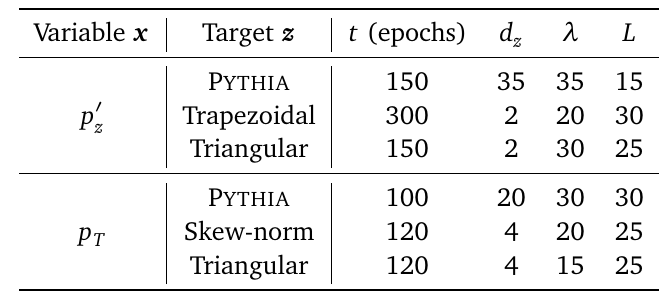
Table 1: The cSWAE training configurations, where x is the input data, z the tar- get latent-space distribution, t the number of epochs, d space, λ the regularization parameter of the sliced-Wasserstein loss, and L the num- ber of latent space projections